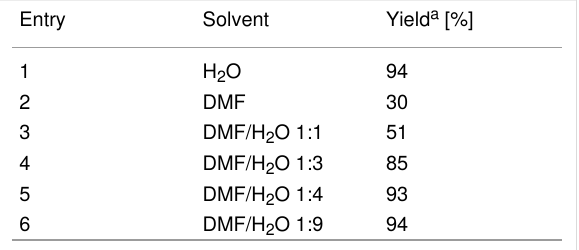
Table 3: Optimization of the continuous flow hydrogenation of N 3 - β -CD ( 3